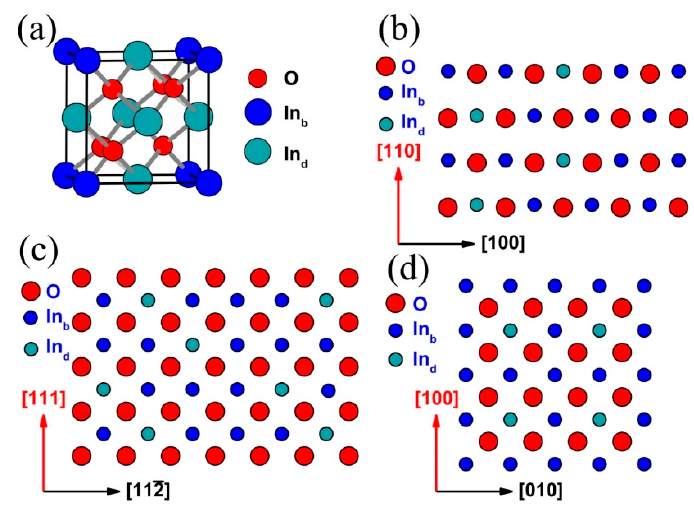
Figure 9. Schematic illustration of an undistorted bcc bixbyite In 2 O 3 unit cell. ( a ) Undistorted primitive unit cell; ( b ) Schematic illustration of side view unrelaxed clean (110) surface; ( c ) Schematic illustration of side view unrelaxed clean (111) surface; ( d ) Schematic illustration of side view unrelaxed clean (100) surface.